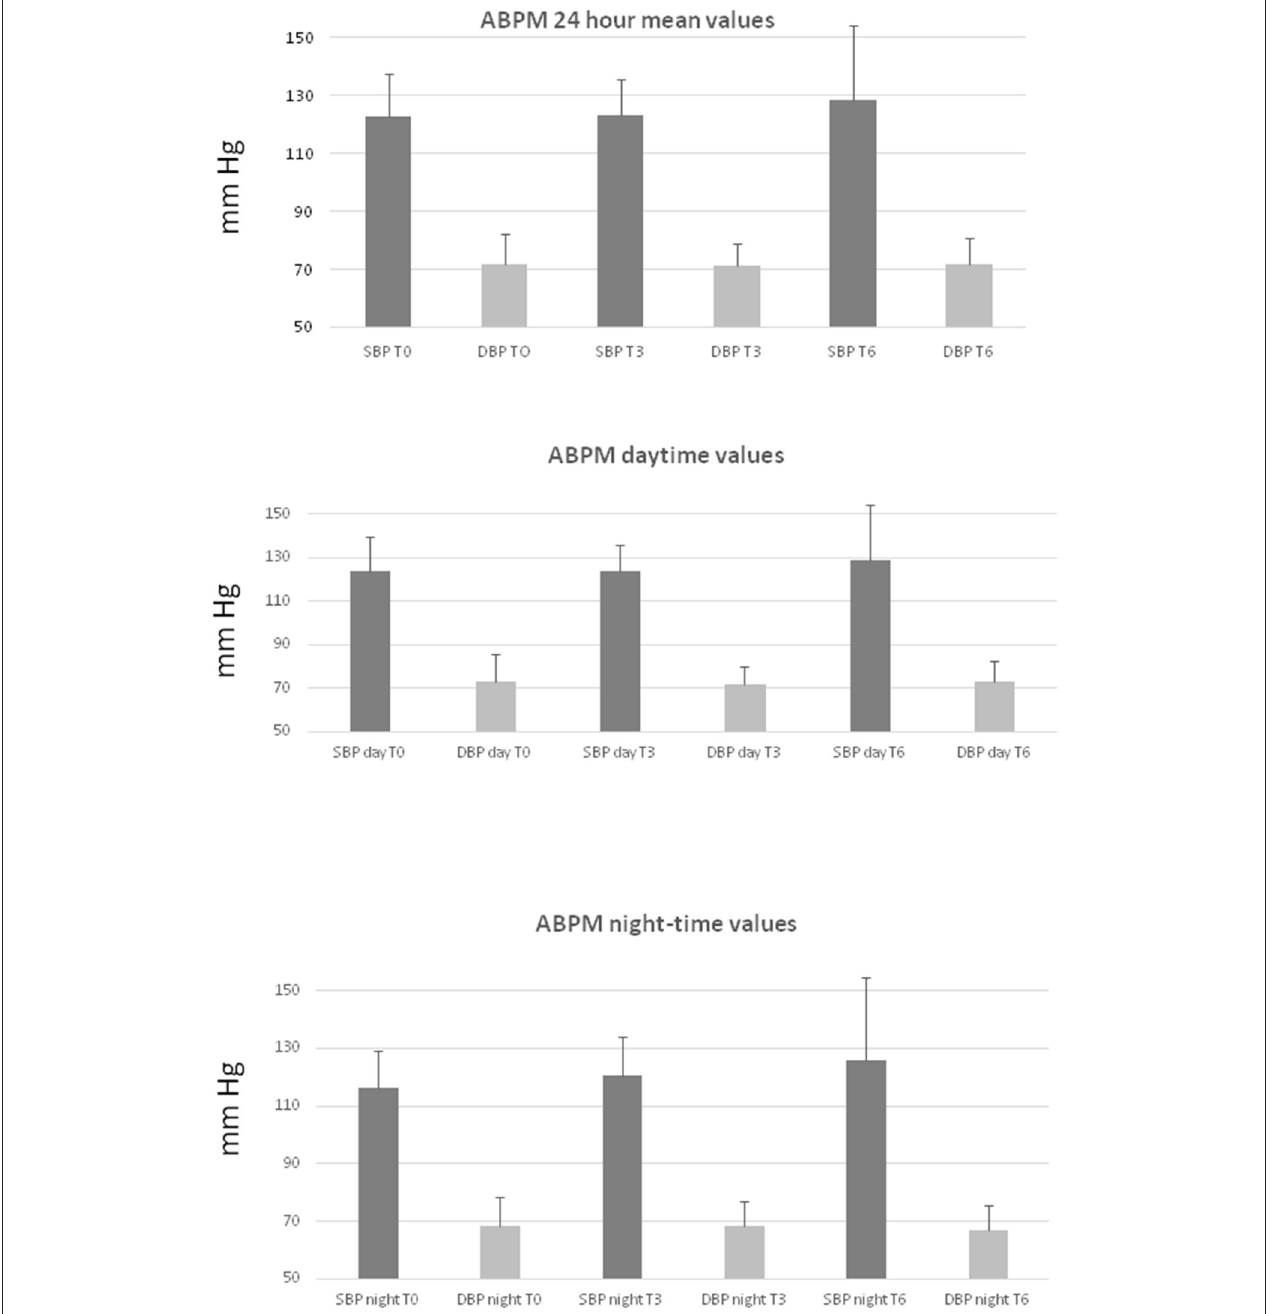
FIGURE 1 | Blood pressure values from ambulatory blood pressure monitoring (ABPM). Top panel: systolic (SBP) and diastolic (DBP) mean 24h values; middle panel: systolic (SBP day) and diastolic (DBP day) daytime values; bottom panel: systolic (SBP night) and diastolic (DBP night) night-time values at the different time points (T0, T3, T6). P = NS between time points. Data are expressed as mean + standard